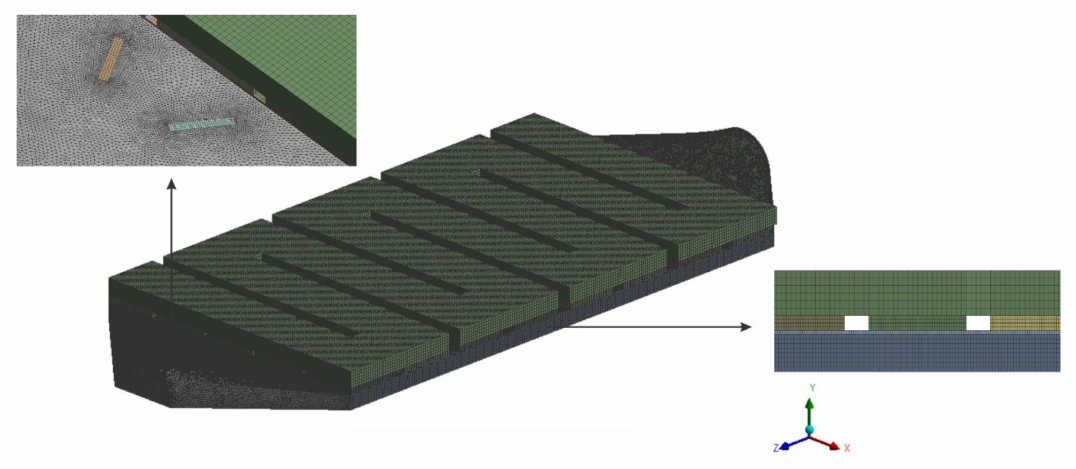
Figure 12. The mesh structure of the computational domain for the simulation of the TEG